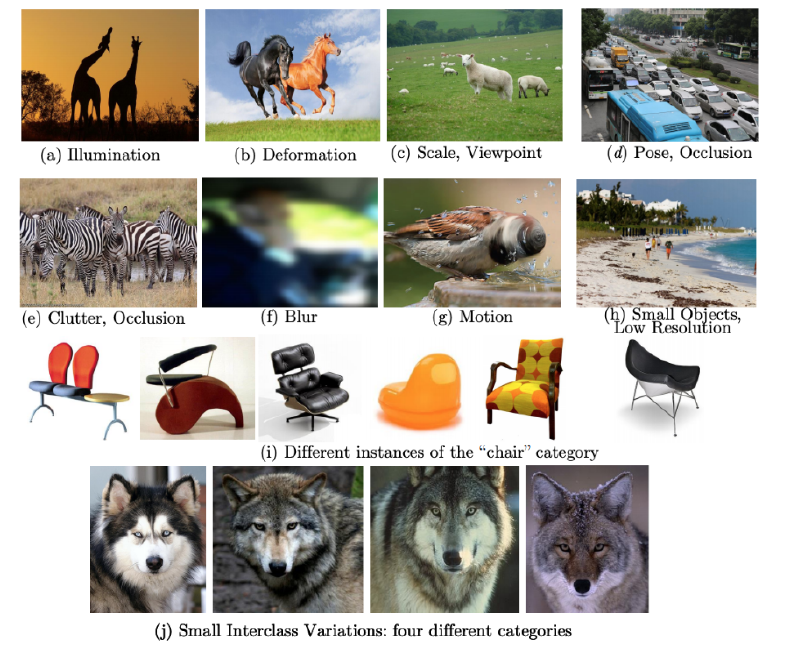
Figure 2. Typical problems in object detection in the same class with variation conditions ( a – h ). Problem in the variations in what is meant to be a single object class ( i ). Objects appear very similar, but in fact, are from four different object classes ( j )